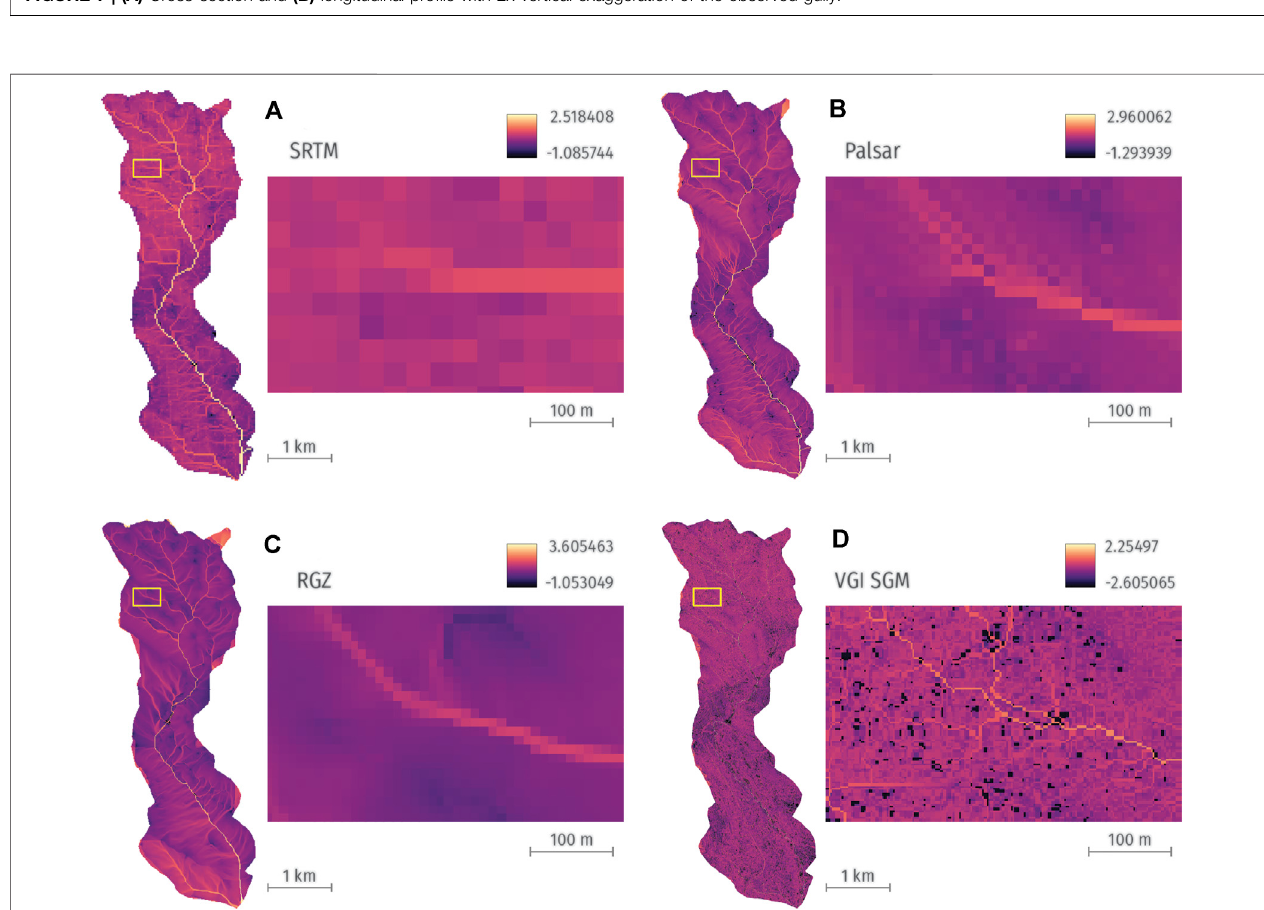
FIGURE 8 | Sediment connectivity maps estimated with the IC model with different resolution DEMs for the Crveni potok catchment: (A) SRTM; (B) PALSAR; (C) RGZ; (D) VGI SGM.